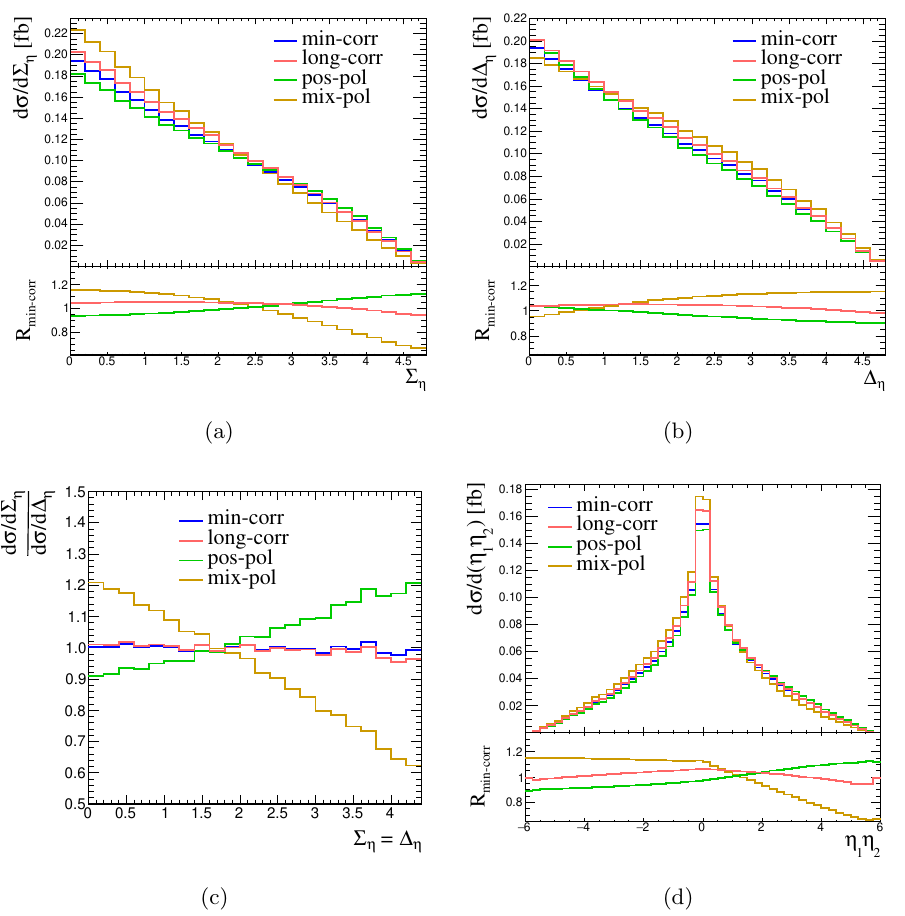
Figure 13 . Upper panels: the distributions in the muon rapidity sum (cid:6) (cid:17) (a) and di(cid:11)erence (cid:1) (cid:17) (b) for the di(cid:11)erent models with the ratio to the min-pol result. Lower panels: the distributions in the correlation sensitive cross section ratio (c) and rapidity product (d). In absence of correla- tions, the cross section ratio is constant while the rapidity product is symmetric around the origin. Distributions are analogous to those in (cid:12)gure 3, here with HL muons within the phase space (5.1).